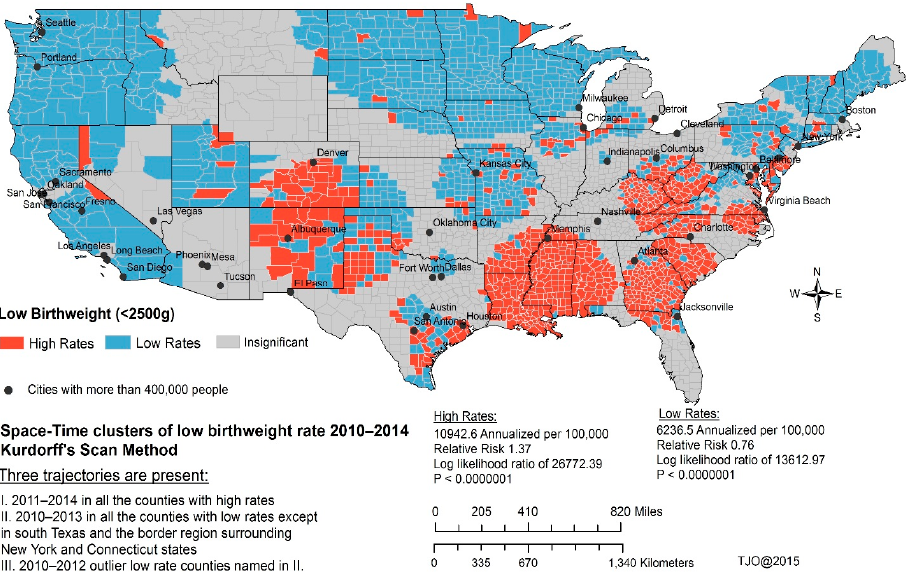
Figure 2. Spatiotemporal clusters of low birthweight for the period between 2010 and 2014.